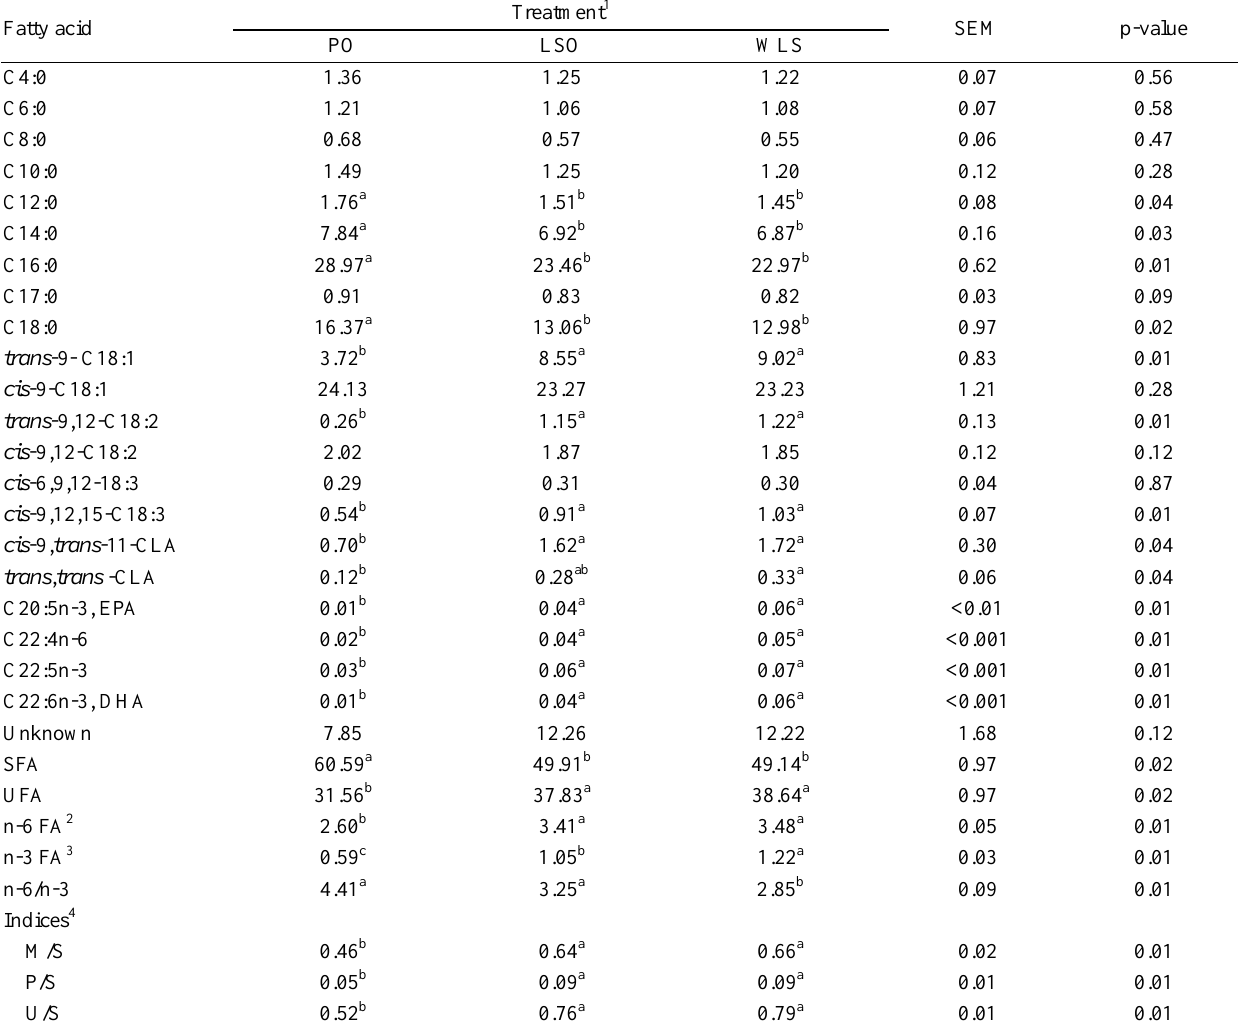
Table 5. Milk fatty acid composition (g/100 g FA) of cows fed linseed oil or whole